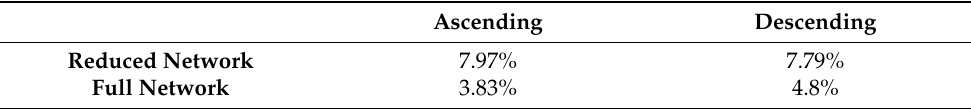
Table 3. Percentage of selected points (threshold =